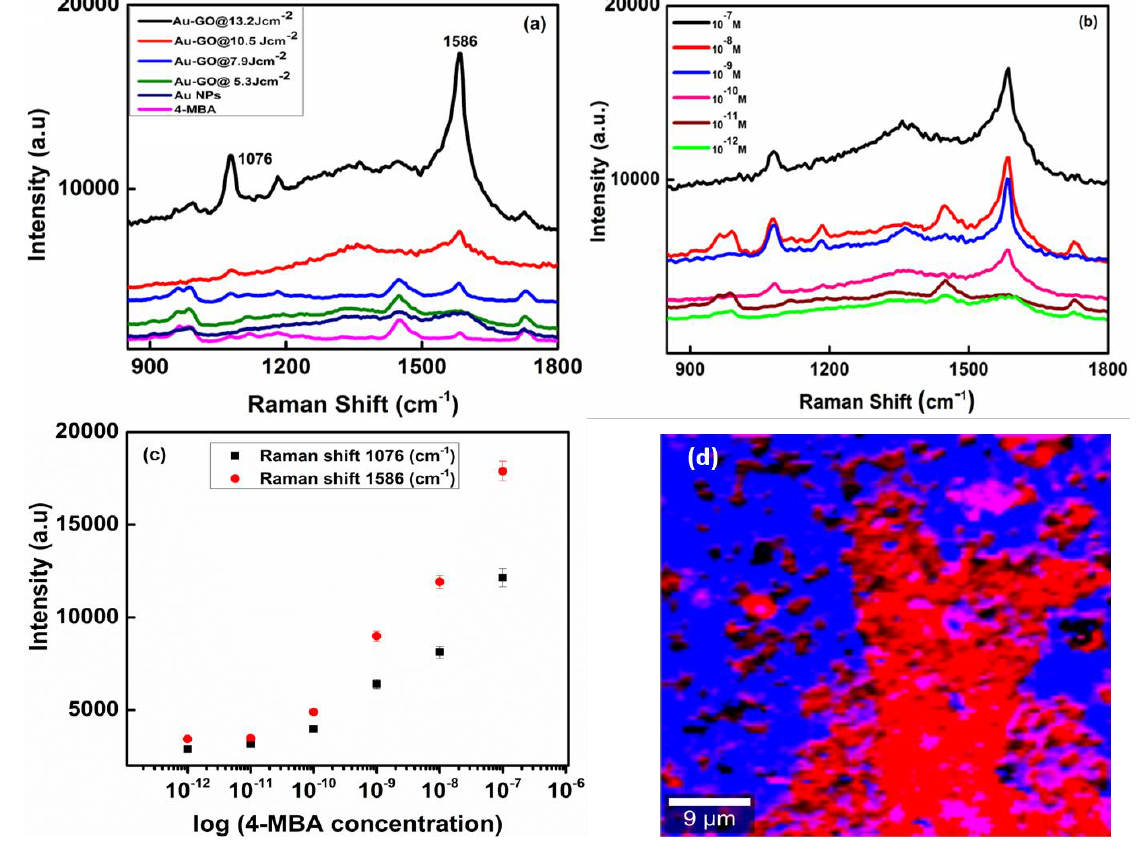
Figure 7. ( a ) The surface enhanced Raman spectroscopy (SERS) spectra of the samples at 10 µ M 4-MBA; ( b ) the SERS spectra of Au-GO at different concentrations of 4-MBA; ( c ) calibration data with respect to the average SERS intensities of the peaks of 4-MBA at 1076 cm − 1 and 1586 cm − 1 with the 4-MBA concentrations; ( d ) the Raman image of the Au-GO, the red region corresponds to the ‘hot spots’.